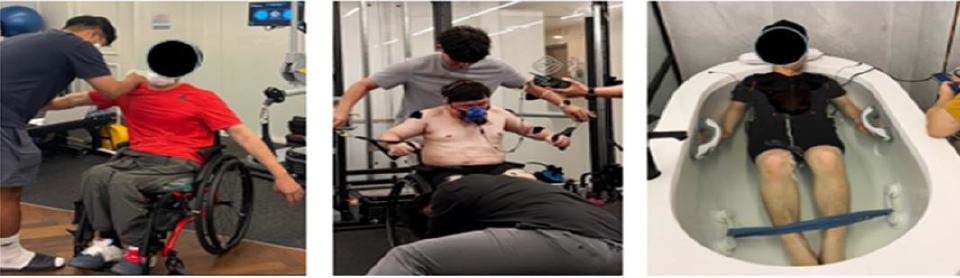
Figure 1. Manual muscle test (MMT) (left), electromyography (EMG) and respiratory gas measurements (middle), and EMS suit training (right).